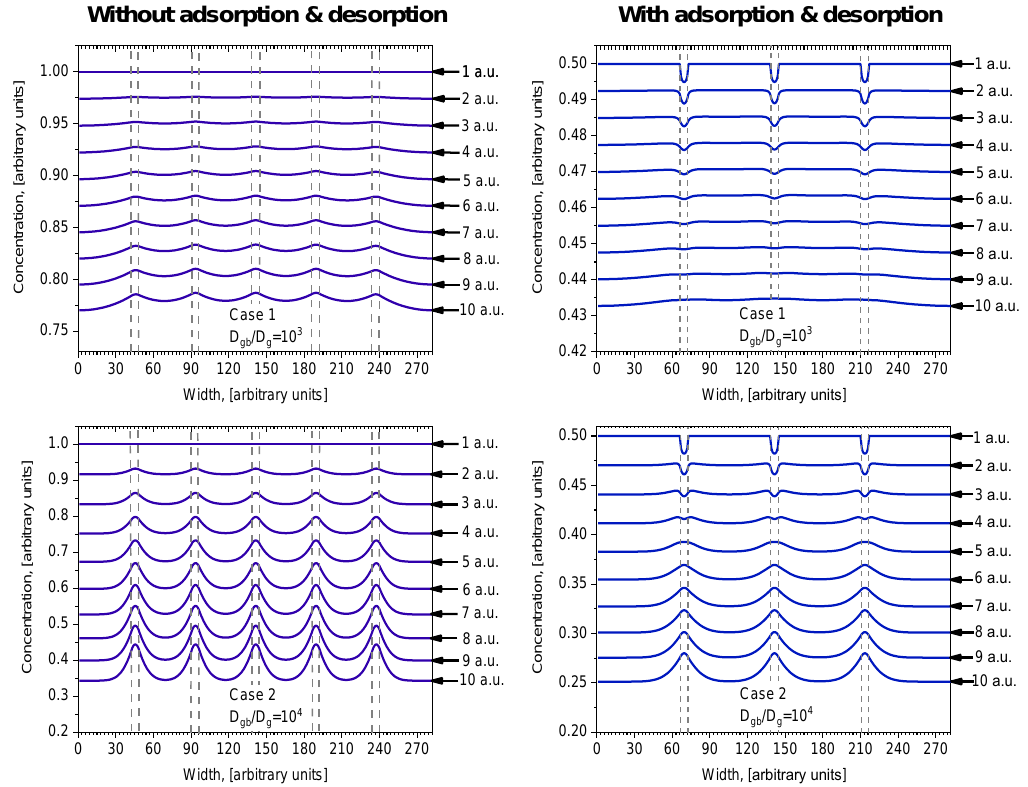
Figure 6. Parallel to the surface concentration profiles for the first 10 monolayers: at left side without adsorption / desorption and at right side with adsorption and desorption; at top for Case 1 and at bottom for Case 2.